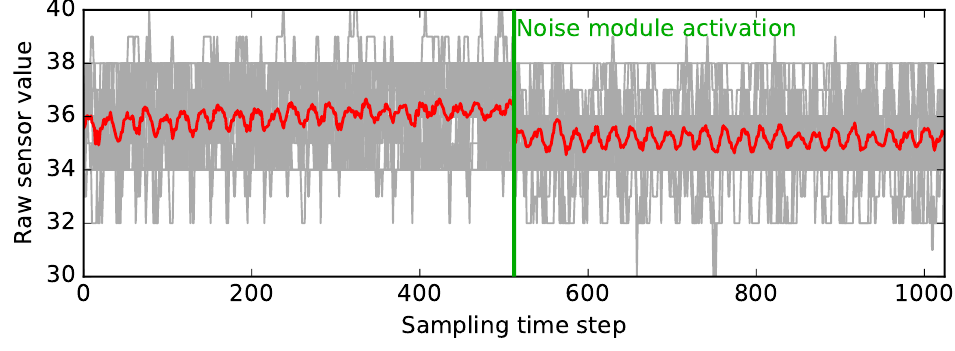
Figure 3: Raw traces (grey) and average (red) over 30 different sensors for 1 , 024 sample points with noise module activation after 512